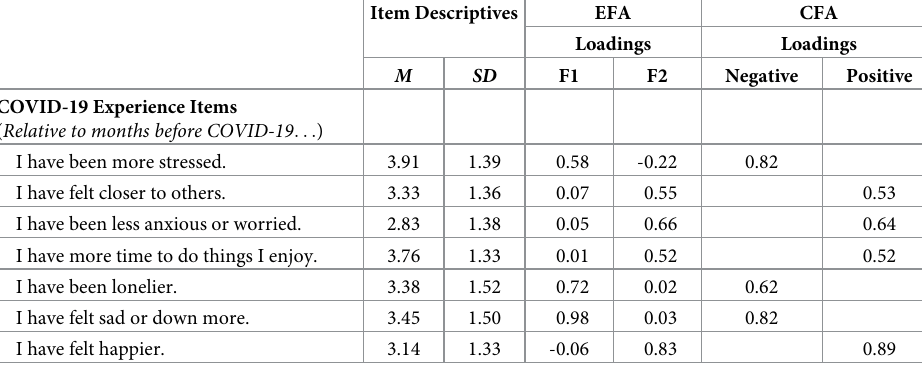
Table 2. Items descriptives and loadings from the exploratory (EFA) and confirmatory (CFA) factor analyses on the COVID-19 experience